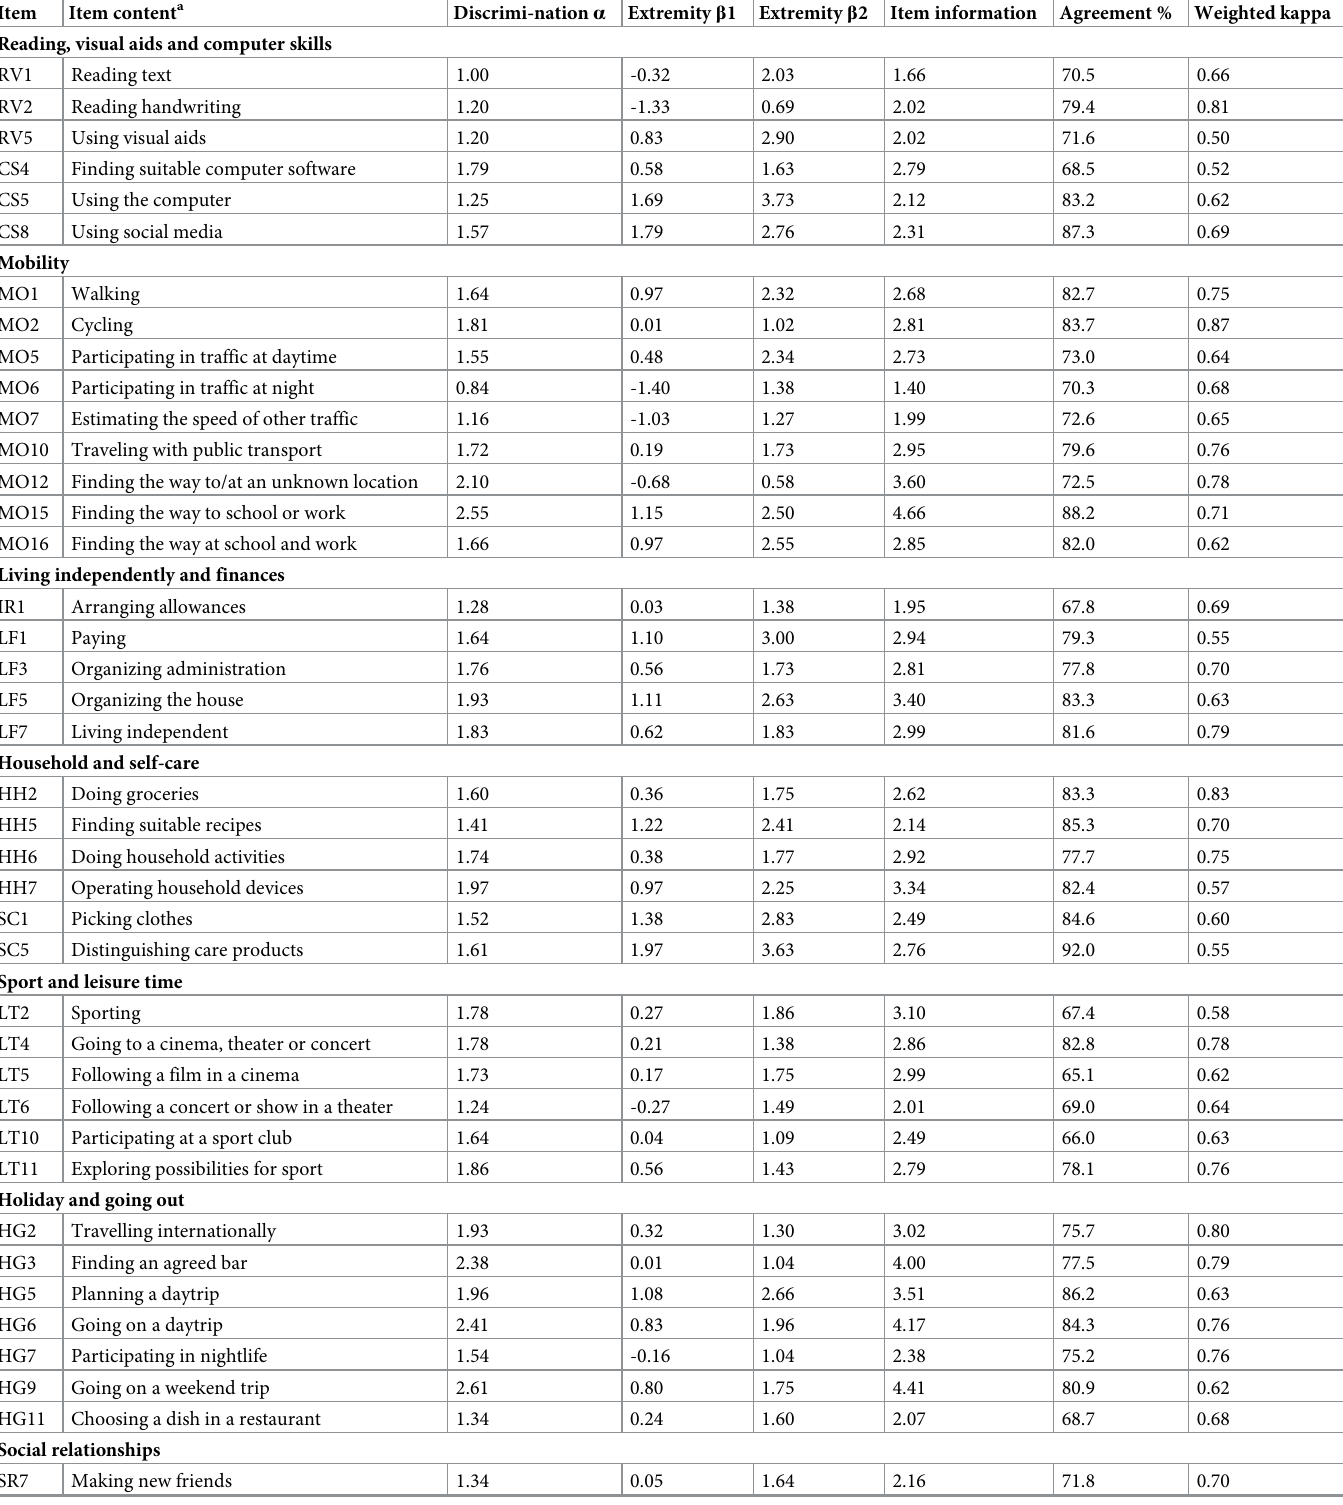
Table 3. GRM item parameter estimates and item information for the 60-item PAI-YA (n = 186). Item Item content